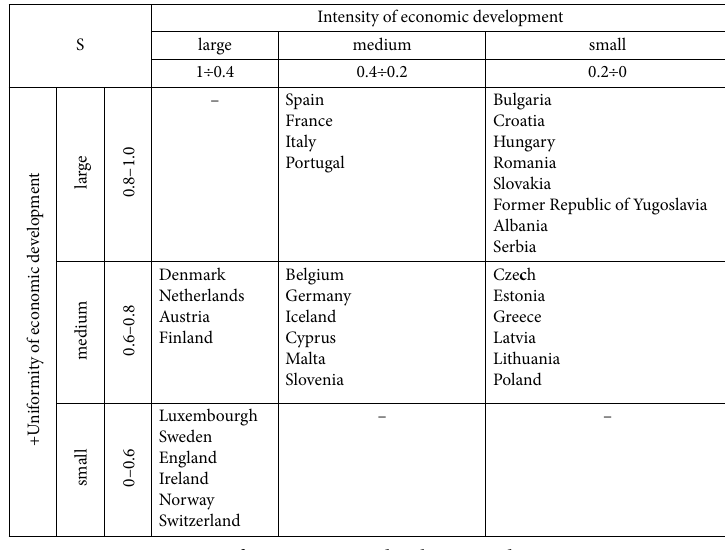
Figure 4. Matrix of EU economic development during 2008–2017 (source: compiled by the authors)